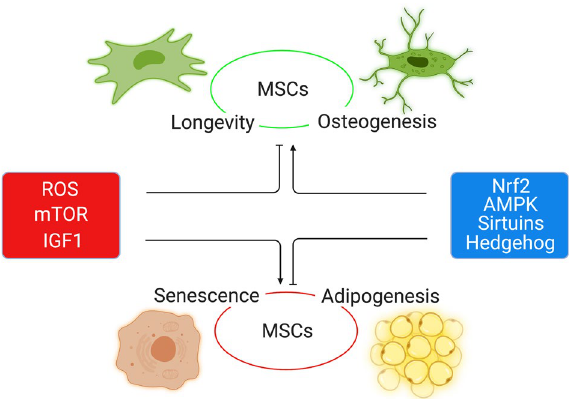
Fig. 3 The major intracellular signaling pathways in cellular senescence and differentiation of MSCs. AMPK, sirtuins, Nrf2, and Hedgehog work as promoters for MSC immortalization and osteogenic differentiation (green); however, ROS, mTOR, and IGF1 are considered as inducers of MSC aging and adipogenic differentiation (red). Activate